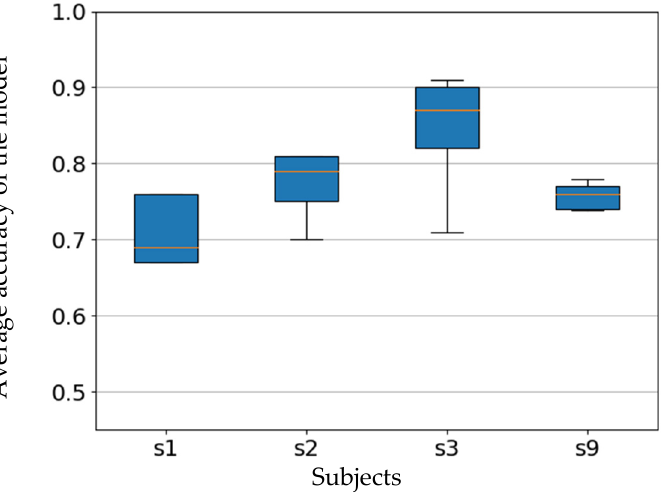
Figure 6. Boxplot of accuracy across different subjects (s1, s2, s3, s9) on top four classification algorithms (CNN, ANN, Ensemble, SVM).